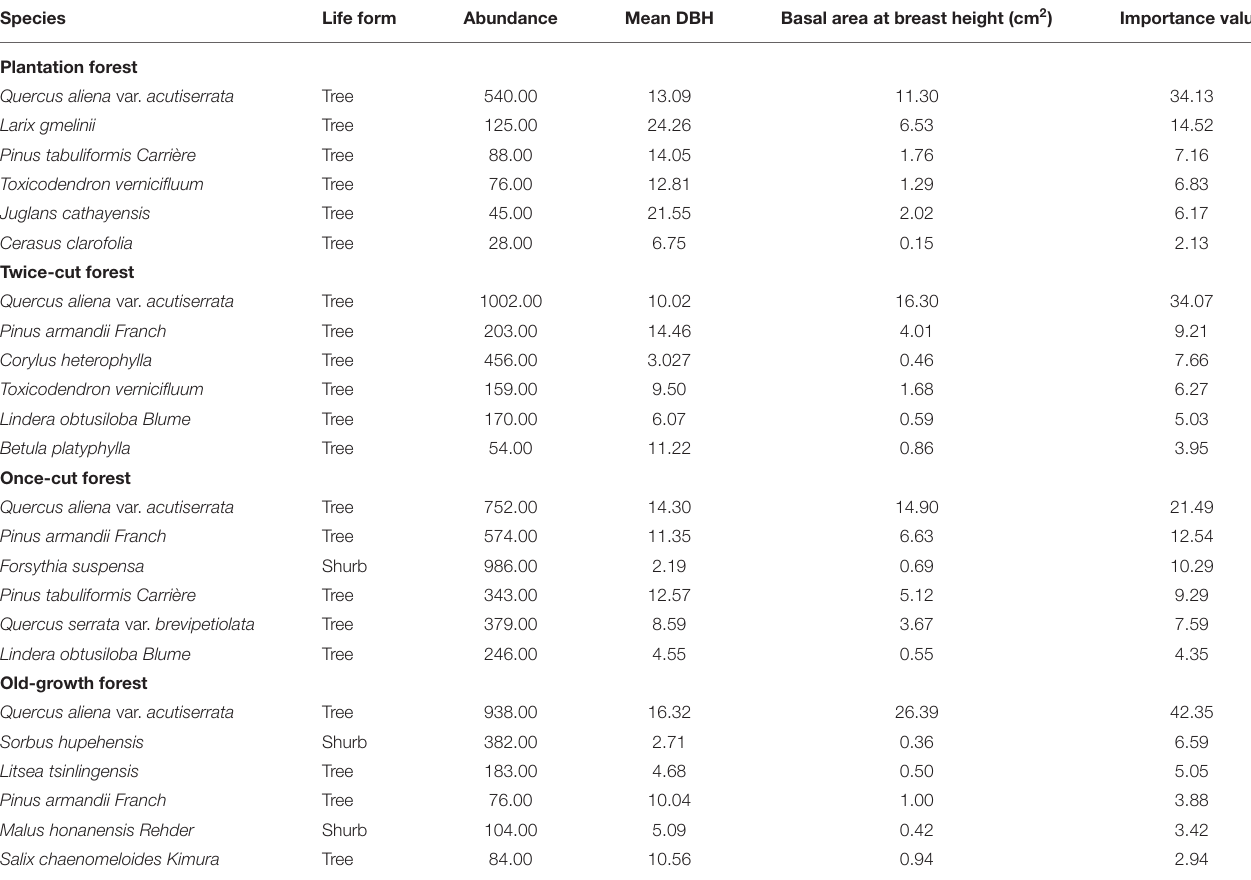
TABLE 1 | Dominant species in the four communities. Species Life form Abundance Mean DBH Basal area at breast height (cm 2 ) Importance